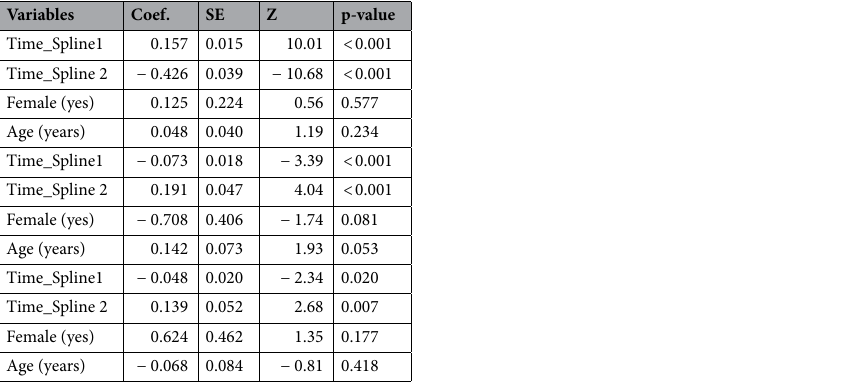
Table 2. Association between PCA Factors and host factors during the controlled human malaria infection (n = 16,139 observations).